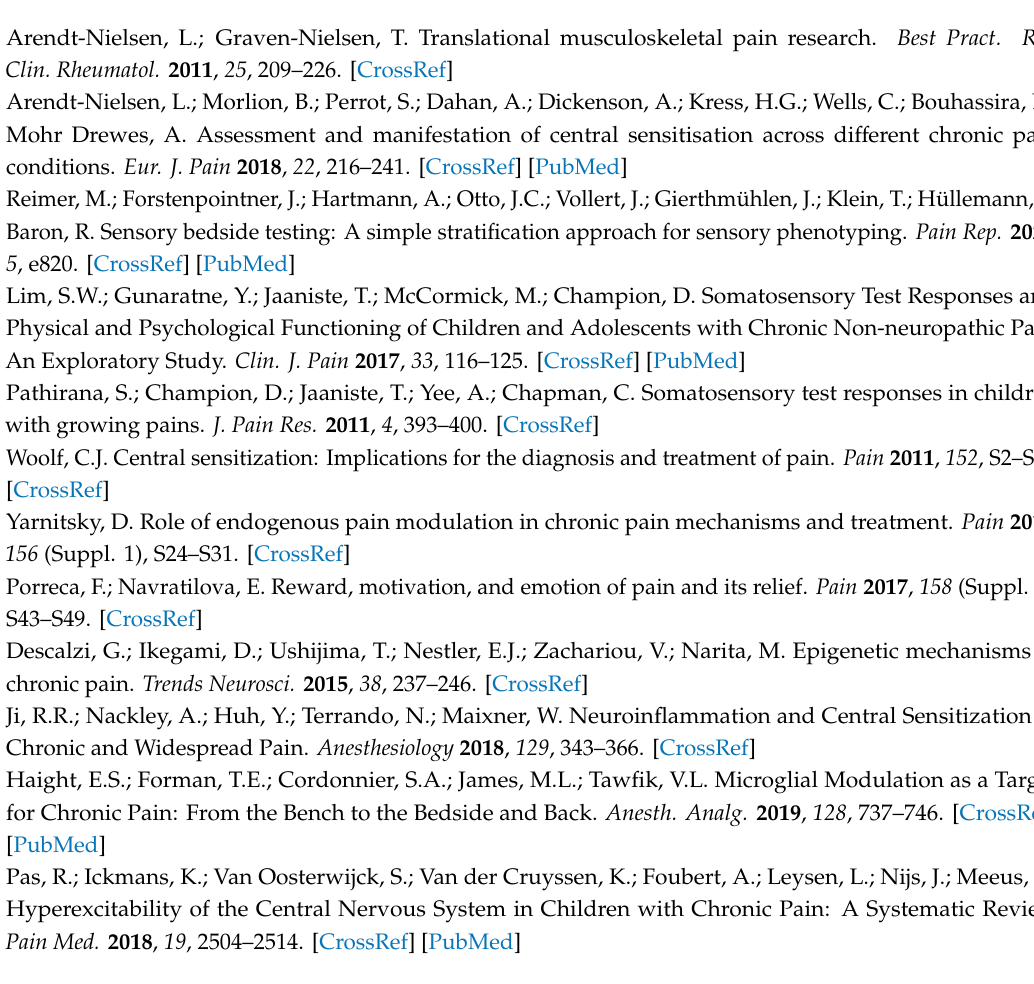
Table S1: Pressure pain threshold (PPT) in clinical samples, children and adolescents; Table S2a: QST in healthy children and adolescents; Table S2b: QST (with at least 2 modalities) in clinical samples of children and adolescents; Table S3: SST instrument sources; Table S4: Multiple regression analyses predicting pain and impaired functioning ( n = 89